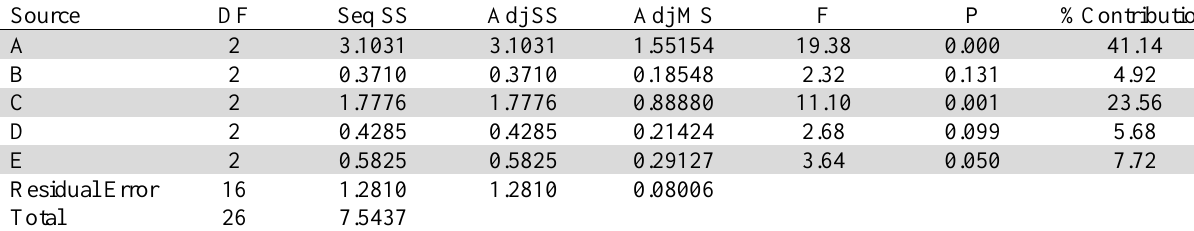
Analysis of variance for S/N